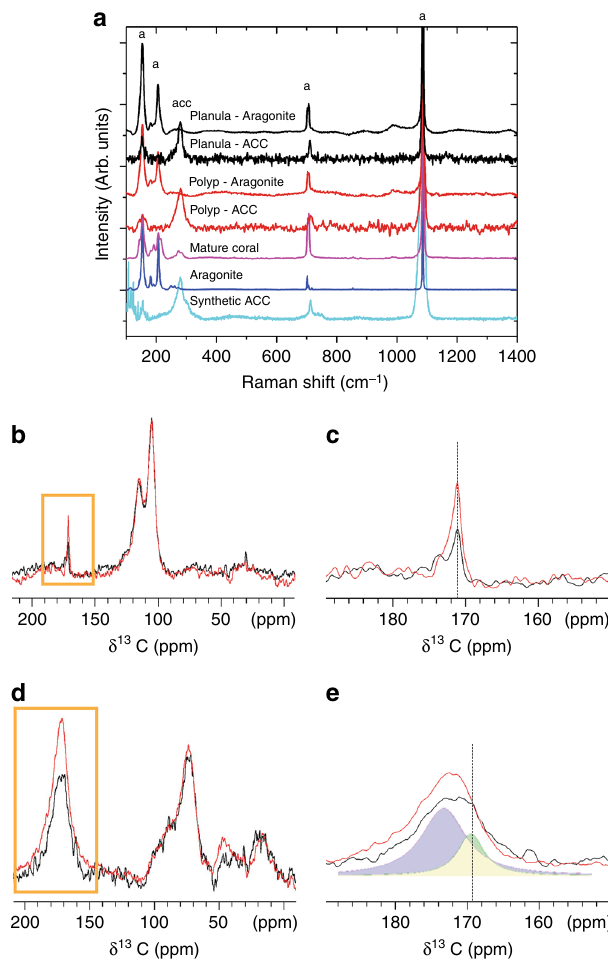
Fig. 4 Spectroscopic mineral determination in the two stages. a Raman spectra of synthetic ACC (cyan), geological aragonite (blue), mature coral (pink), settled primary polyp (red), and pre-settled metamorphosed planula (black), showing the presence of the major aragonite bands and ACC. The main differences are in the low-wavenumber region (100 – 300 cm − 1 ) showing a clear signature of ACC in both early stages. b – e 13 C ssNMR spectra of the entire pre-settled metamorphosed planulae (black) and primary polyps (red). b 13 C direct excitation spectra of the two developmental stages. c The carbonate/carbonyl region of the spectra in b , showing the marked increase in the content of the bulk mineral after settlement. d 13 C cross-polarization spectra of planulae and polyps enhancing the carbons with vicinal protons. e Magni fi cation of the carbonate/carbonyl region of the spectra in d , showing changes of the disordered CaCO 3 line upon settling due to maturation of the carbonate ions. Dashed lines mark the location of the carbonate peaks in c and e . Peak analysis can be found in supporting information (Supplementary Figures 6 and 7). In the Raman spectra, typical peaks of aragonite (a) and ACC (acc) are